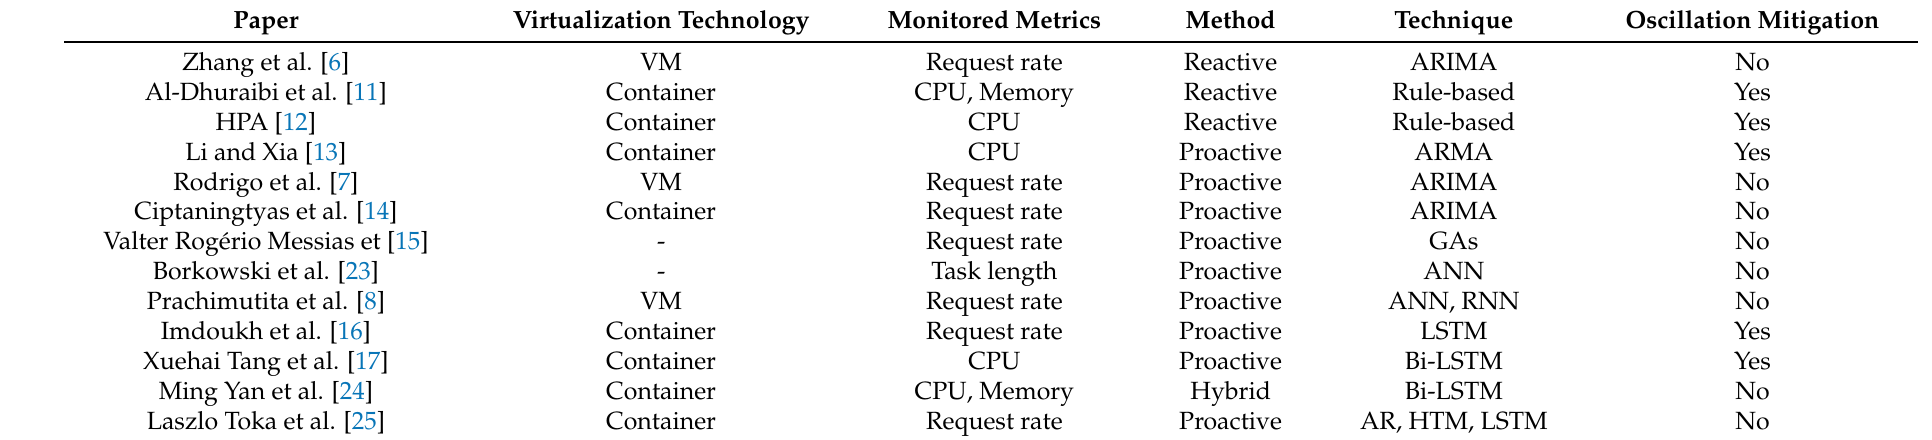
Table 1. Overview of recent works related to autoscaling